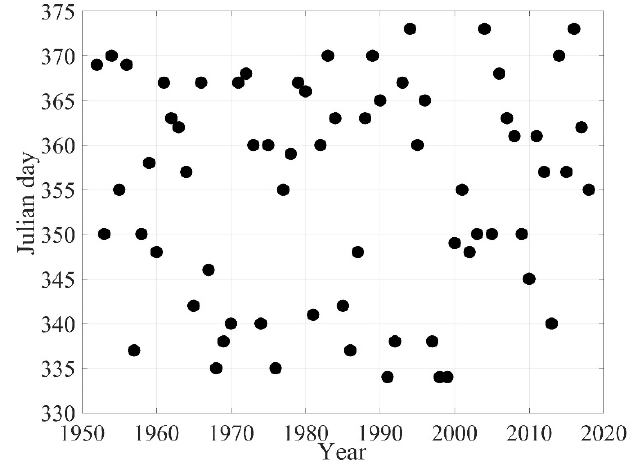
Figure 5. Modeled freezing-up date (black circles) for each winter season during study period. The modeled breakup date showed a clear trend toward early occurrence (Figure